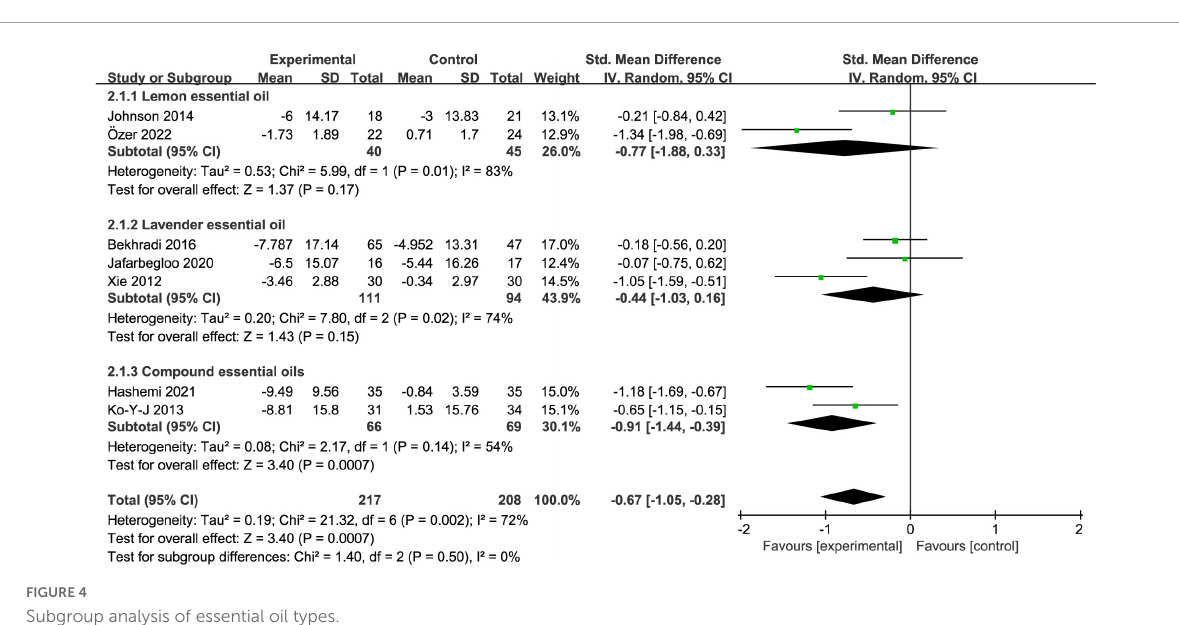
FIGURE4 Subgroup analysis of essential oil